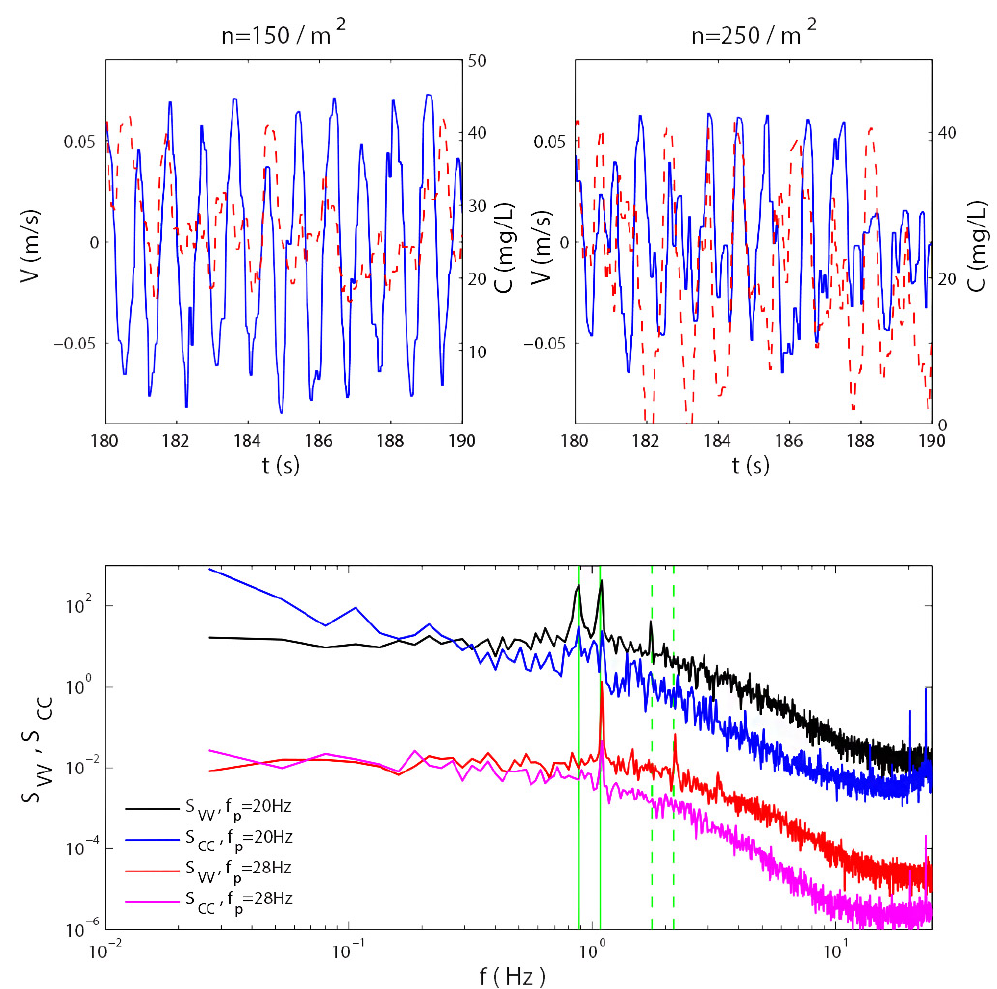
Figure 7. Top: transverse velocity (blue solid line) and concentration (red dashed line) fluctuations due to transverse standing waves gener- ated with increasing density. Bottom: velocity and concentration spectra for n = 250m − 2 , at the minimum and maximum flow rates consid- ered. Vertical solid green lines show the expected frequencies for modes 2 (0 . 88Hz) and 3 (1 . 08Hz) of the flume, and dashed green lines show twice such frequencies . Actual magnitudes of S vv and S CC have been altered to improve